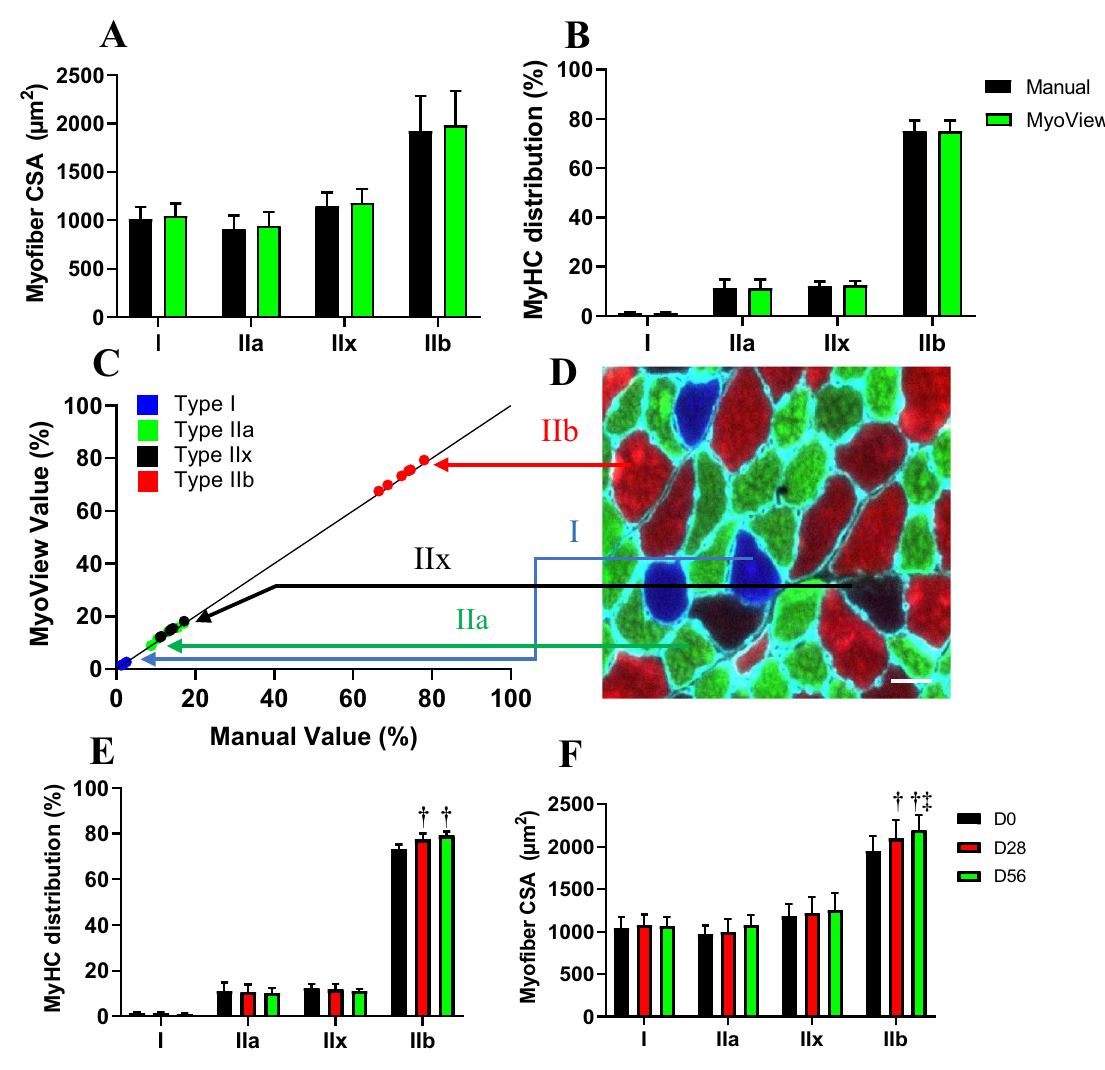
Figure 5. MyoView is comparable to manual quantification for analysing different myofibers. ( A-B ) Myofiber CSAs and distributions were not different when determined with MyoView or by manual quantification ( P > 0.92). Results of manual analysis of 6 images from 3 investigators are shown. ( C ) Proportions determined manually are on the y-axis and proportions determined by MyoView are on the x-axis. ( D ) MyHC I fibers indicated by blue symbols, MyHC IIa indicated by green symbols, MyHC IIx indicated by black symbols, and MyHC IIb indicated by red. ( E ) The effect of HIIT on MyHC distribution (measured with MyoView). ( F ) The effect of HIIT on myofiber CSA in different fiber types (measured with MyoView). † P < 0.05 as compared with D0. ‡ P < 0.05 as compared with D28. Bar = 25